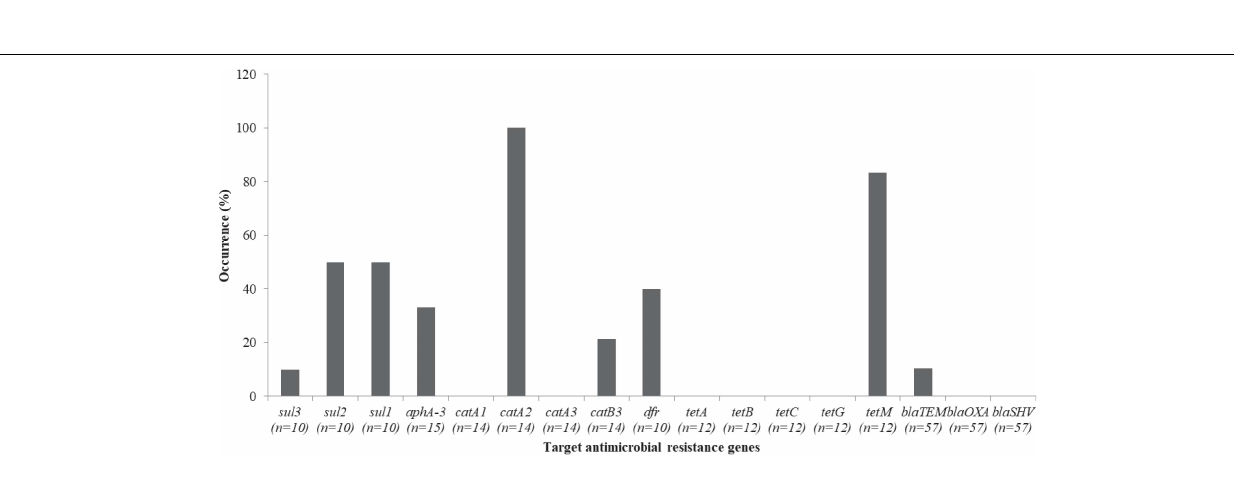
FIGURE 7 | Antibiotic resistance genes in the V. parahaemolyticus